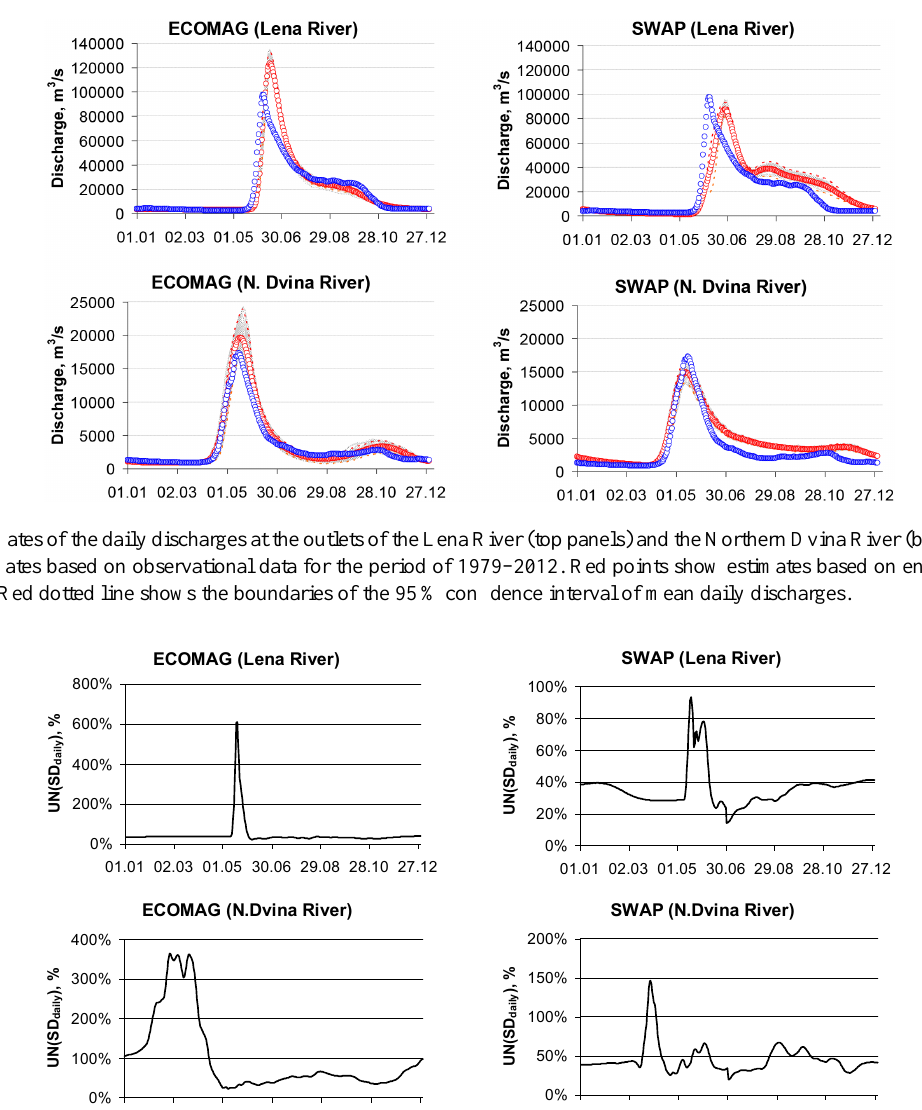
mean hydrographs (an averaged response to ensemble input) and the other simulated by the hydrological mod- els using one meteorological input obtained by averag- ing over 45 ECHAM5 outputs (a response to the ensem- ble averaged